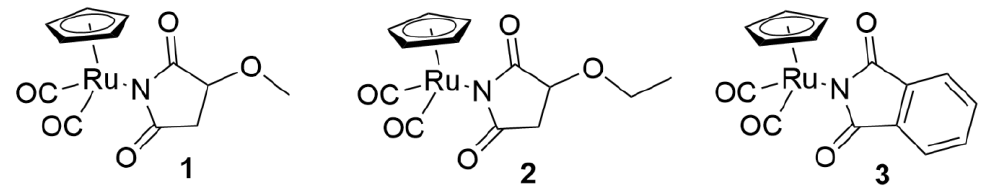
Figure 1. The structures of the ruthenium complexes 1 – 3 .